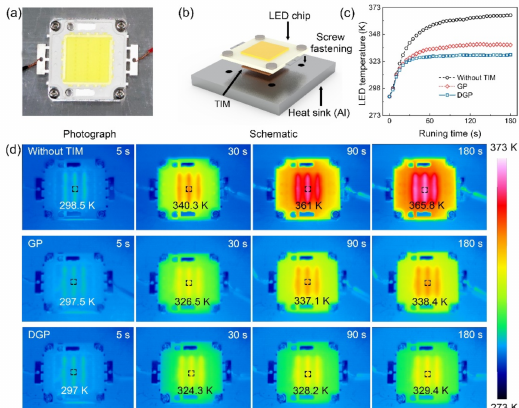
Figure 4. ( a ) Experimental setup and ( b ) schematic configuration for comparing the cooling efficiency between GP and DGP based on the heat dissipation of an LED. ( c ) Temperature evolution of the LED chip as a function of running time, with the corresponding IR images shown in ( d